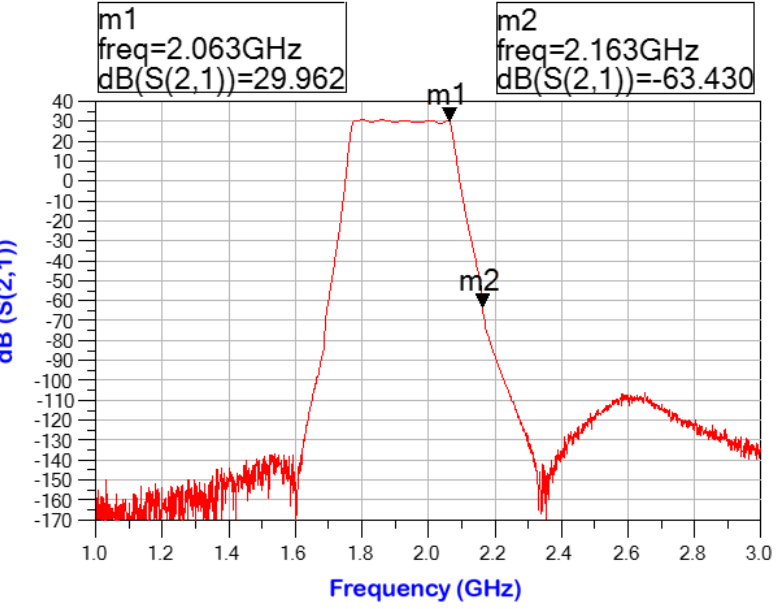
Figure 6. Transmission coefficient of the HTSC radio head .